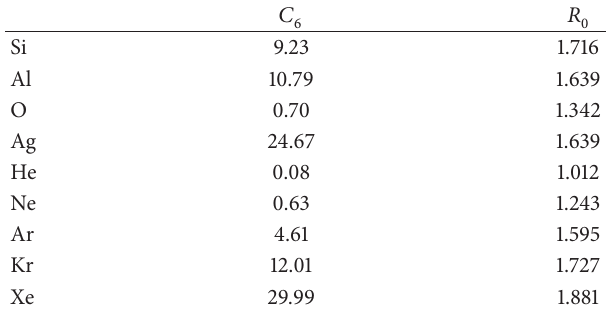
Table 1: Dispersion coefficients 𝐶 6 (J ⋅ nm 6 /mol) and van der Waals radii 𝑅 0 (˚A) [13].